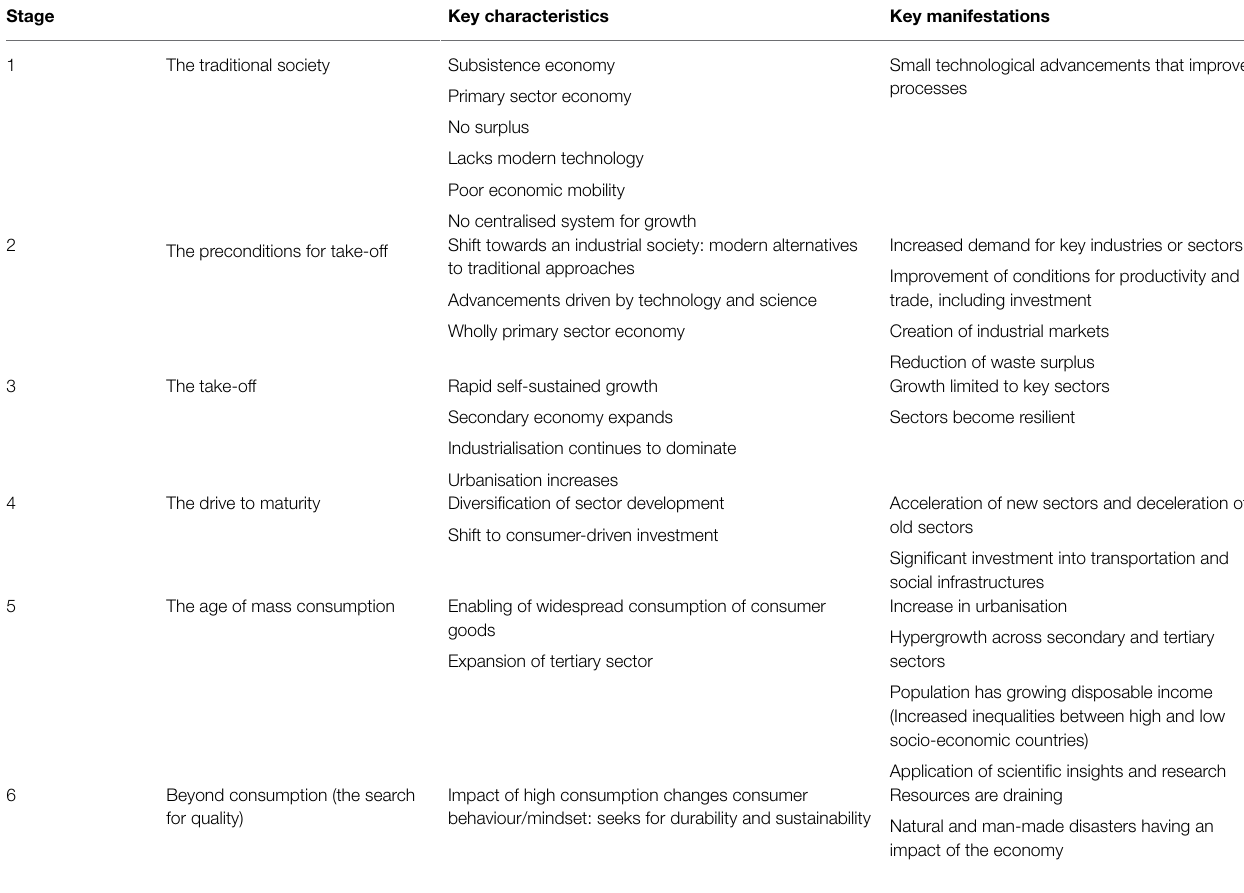
TABLE 1 | Rostow’s stages of economic growth.